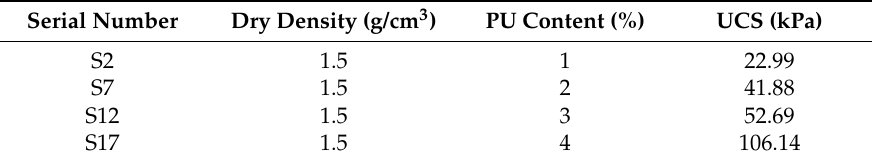
Figure 4. Test results of ( a ) effect of fiber content on unconfined compressive strength (UCS) of PU treated specimens at 1.5 g/cm 3 dry density; ( b ) linear fitting for the relationship between the UCS and fiber content. Table 6. UCS of PU-treated sand without fiber inclusion (from Liu et al., 2017).